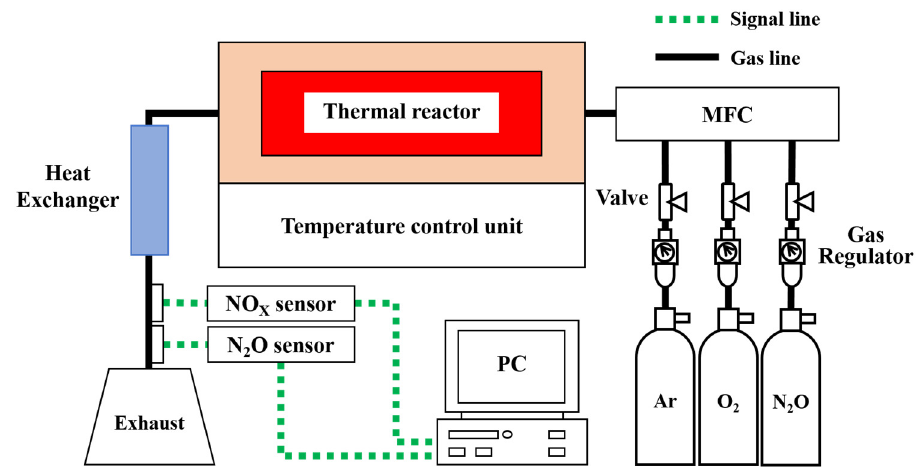
Figure 2. A scheme of the experimental setup [27].